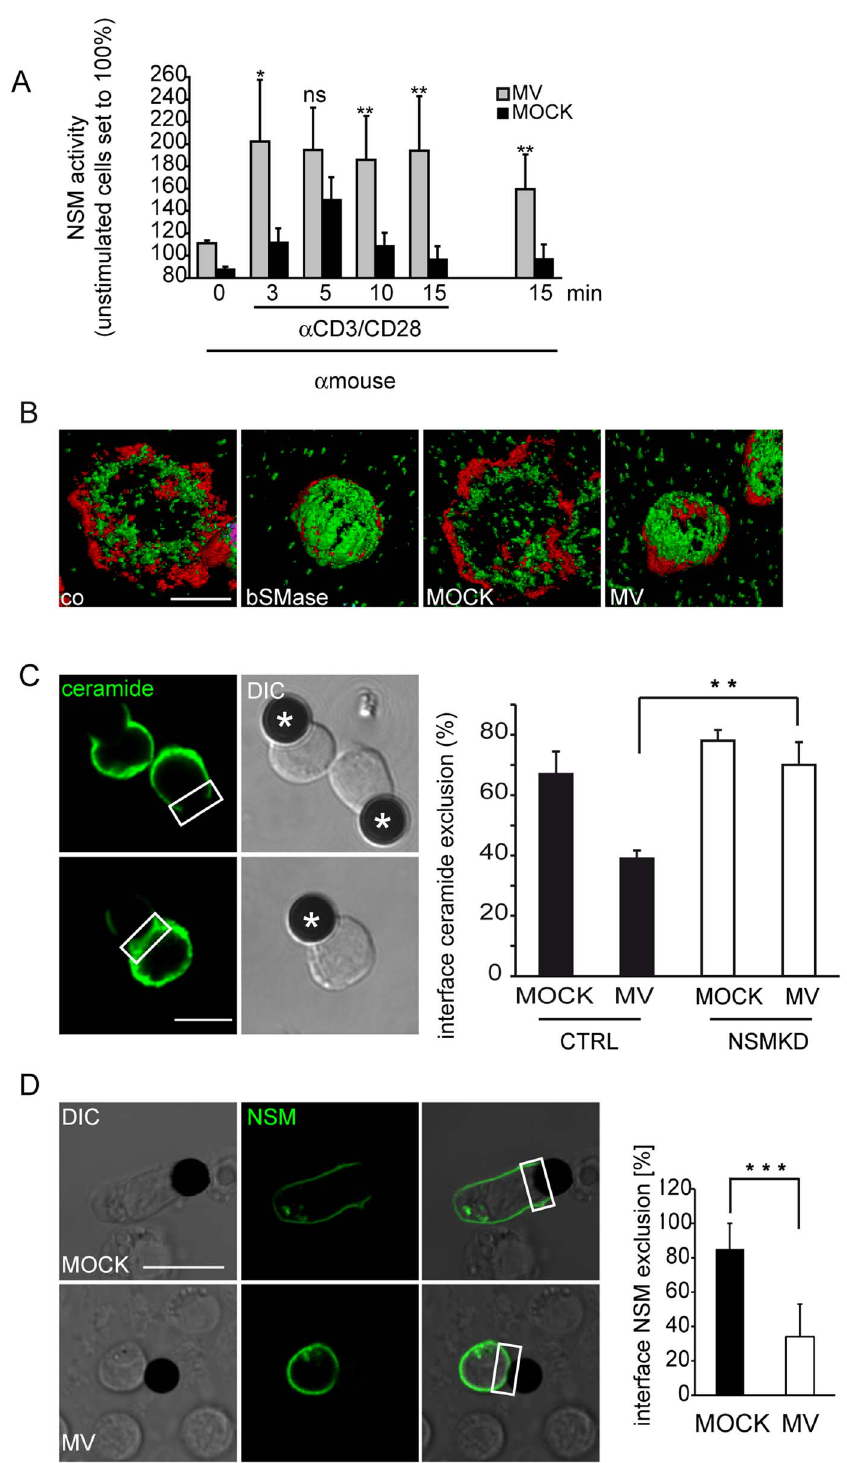
Fig. 4. MV causes early superactivation of NSM and ceramide accumulation within stimulatory interfaces. A. NSM activity was determined in membrane extracts isolated from T cells exposed to MV or MOCK prior to a a˜CD3/CD28 activation for the time intervals indicated. Time point ’0 and 15 min’ (right) measured NSM activity in T cells exposed to MV but not stimulated by a a˜CD3/CD28 ligation. B. Ceramide (green) and f- actin (red) were detected in T cells pre-exposed to bSMase, MOCK or MV and seeded onto co-stimulatory slides for 15 min. Representative examples of 50 cells analyzed per culture are shown after 3D deconvolution. C. The percentage of conjugates excluding ceramide from the interface between a a˜CD3/CD28 coated beads (marked by asterisks) and CTRL or NSMKD T cells pre-exposed to MV or MOCK was determined 15 min following conjugate formation, fixation and staining by a -ceramide antibody. D. 24 h following p-NSM2-GFP nucleofection, T cells were exposed to MOCK or MV, conjugated to a a˜CD3/CD28 coated beads and the frequency of conjugates excluding NSM2-GFP from the interface in both cultures was